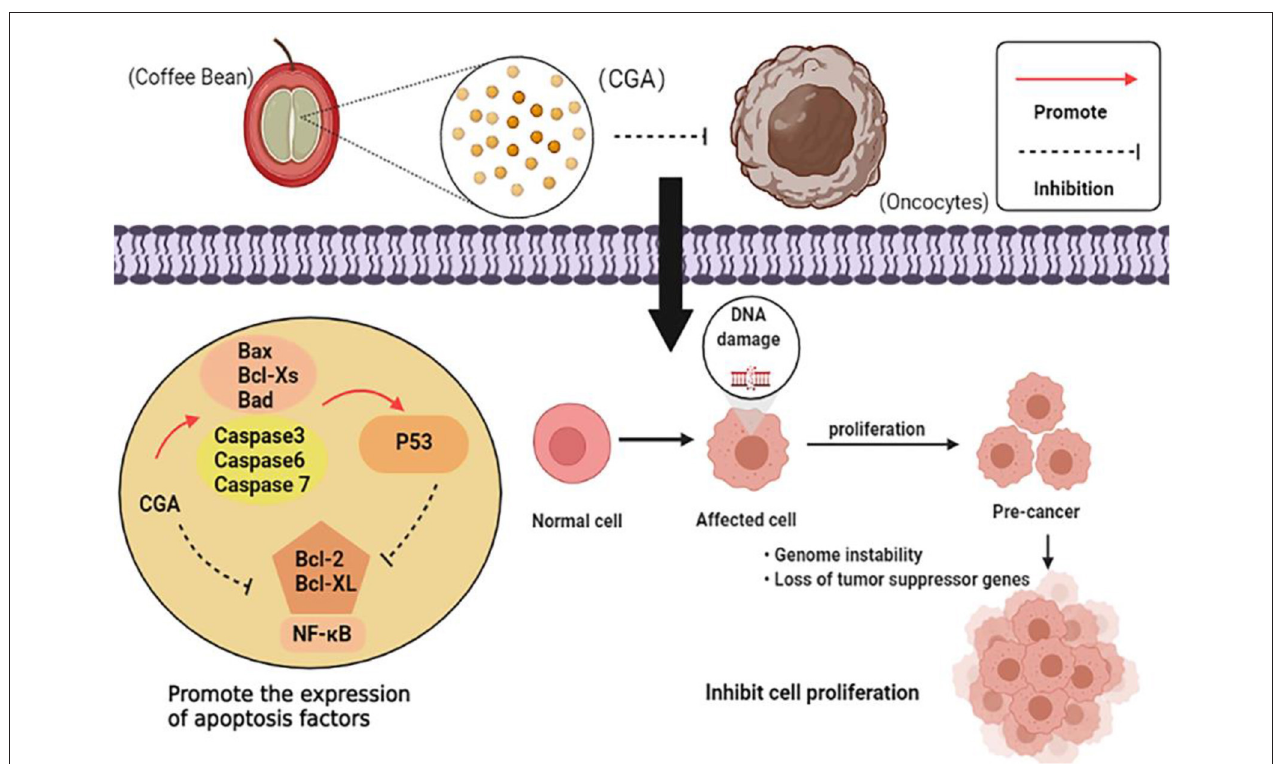
FIGURE 7 | Anti-tumor mechanism of